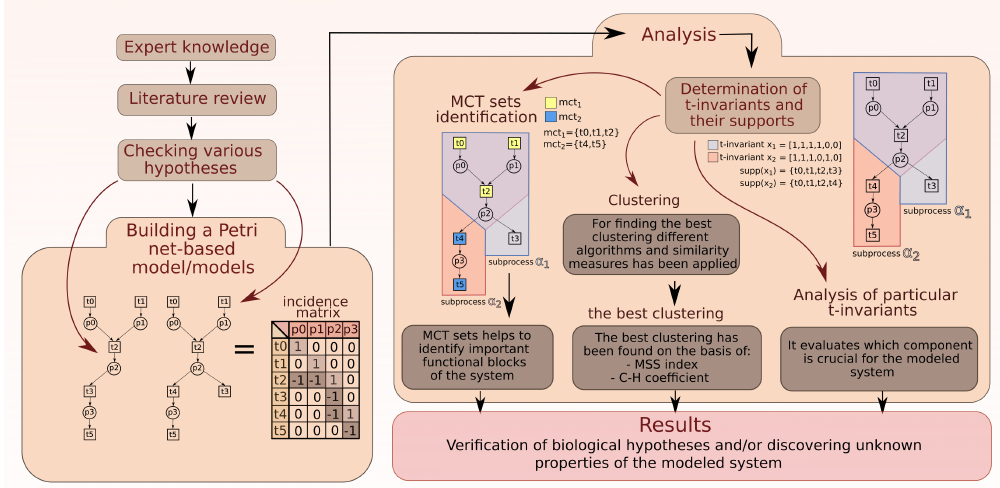
Figure 6. The scheme of work: creating models, methods of analysis, and obtaining